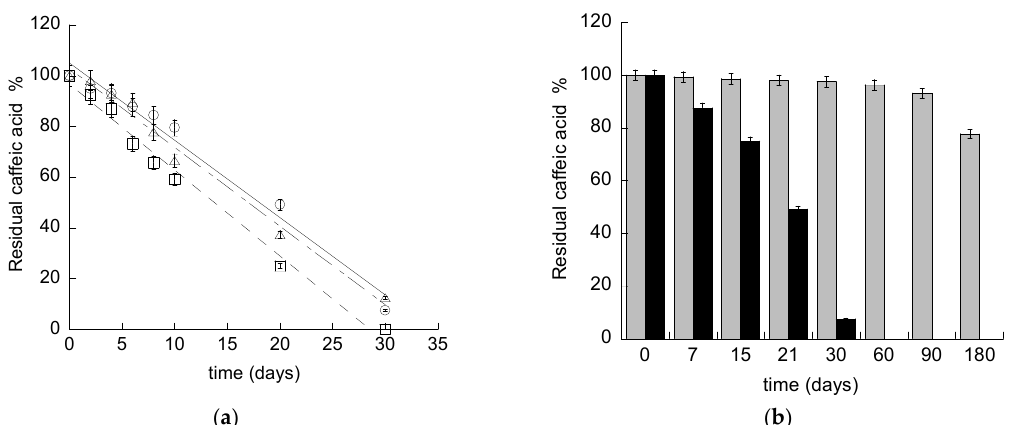
Figure 1. ( a ) Caffeic acid content in aqueous solution stored at 22 (open circle), 4 (triangle), or 40 (square) °C for 30 days. ( b ) Caffeic acid content in aqueous solution (black) or in ethosome (ETHO) (grey) stored at 22 °C.